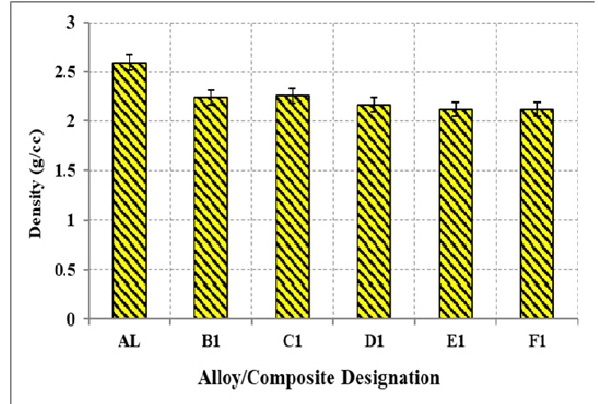
Figure 4. Density values of unreinforced and graphene/CNT reinforced aluminium hybrid